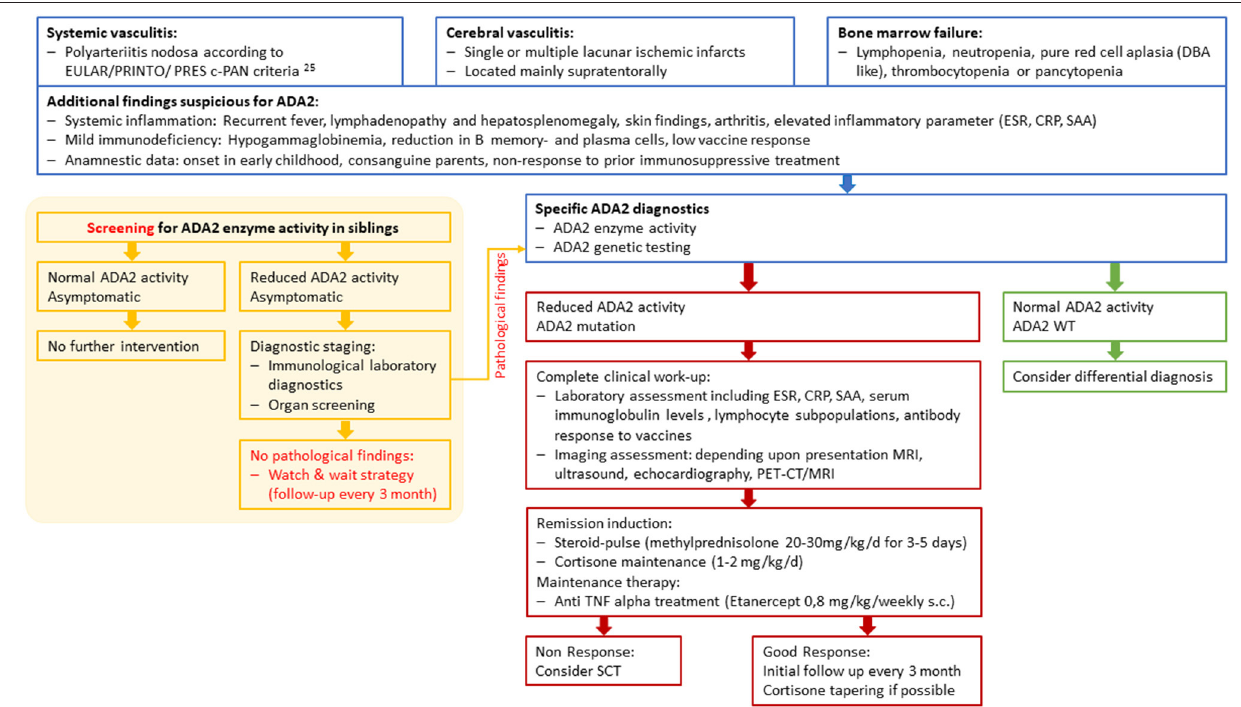
transfusion frequency of every 2–3 weeks ( Figure 1F ). After 6 months, TNF alpha blocking therapy was